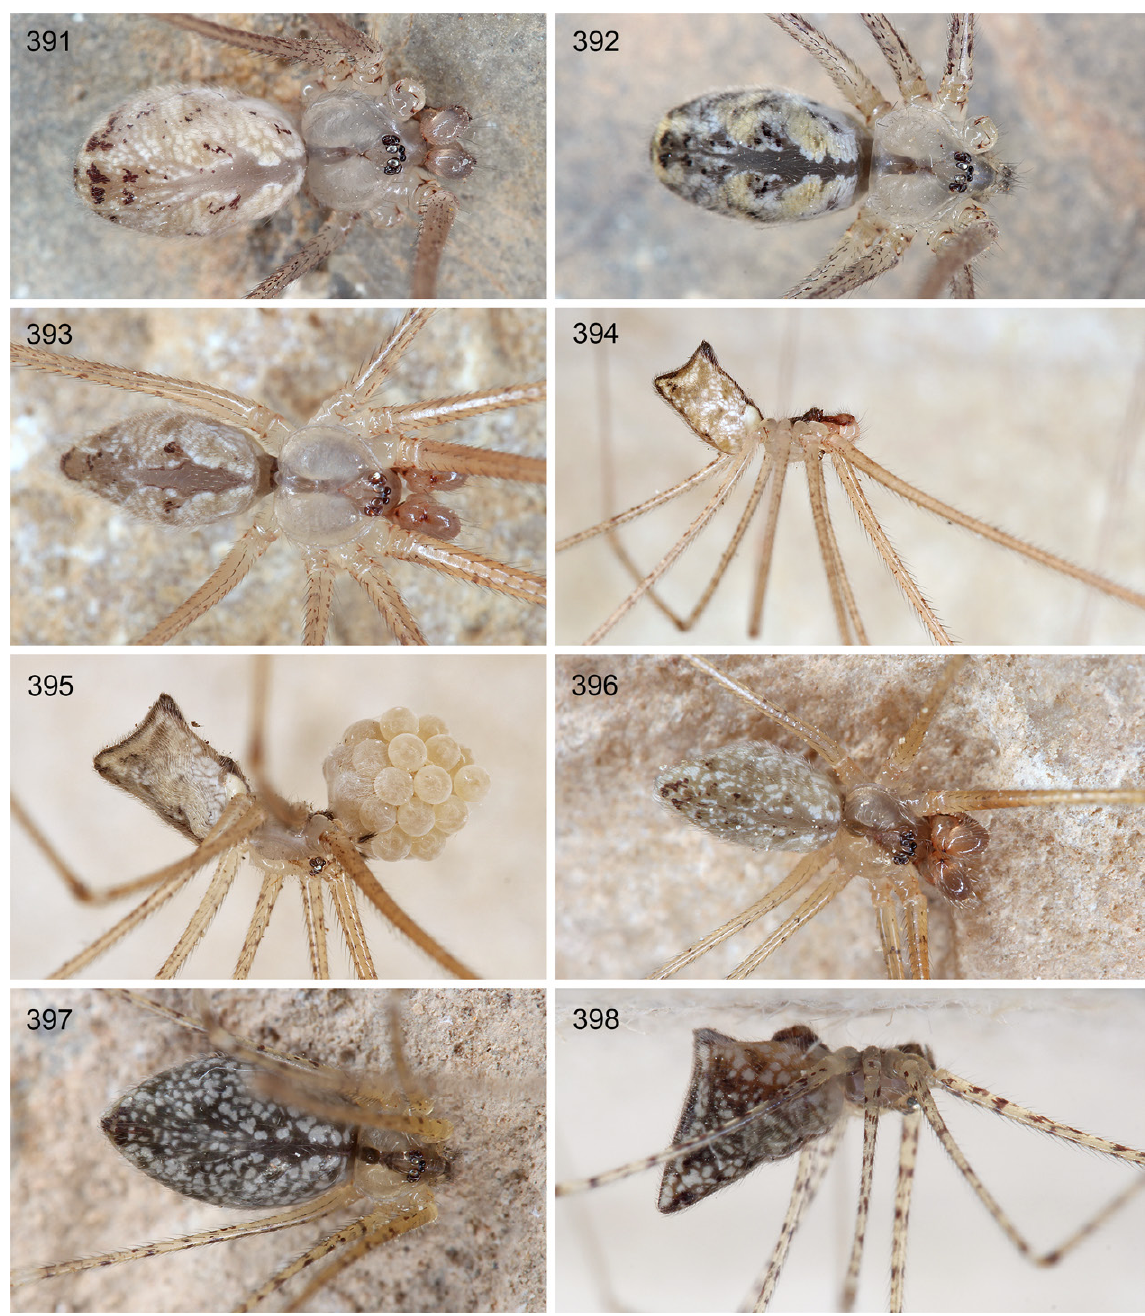
Figs 391–398. Crossopriza Simon, 1893, live specimens. 391–392 . C. sahtan sp. nov., male and female from Oman, Wadi Ghul. 393–395 . C. tiwi sp. nov., males and female with egg-sac from Oman, Wadi Tiwi. 396–398 . C. dhofar sp. nov., male and female from Oman, Ain Razad, and female from Oman, Wadi